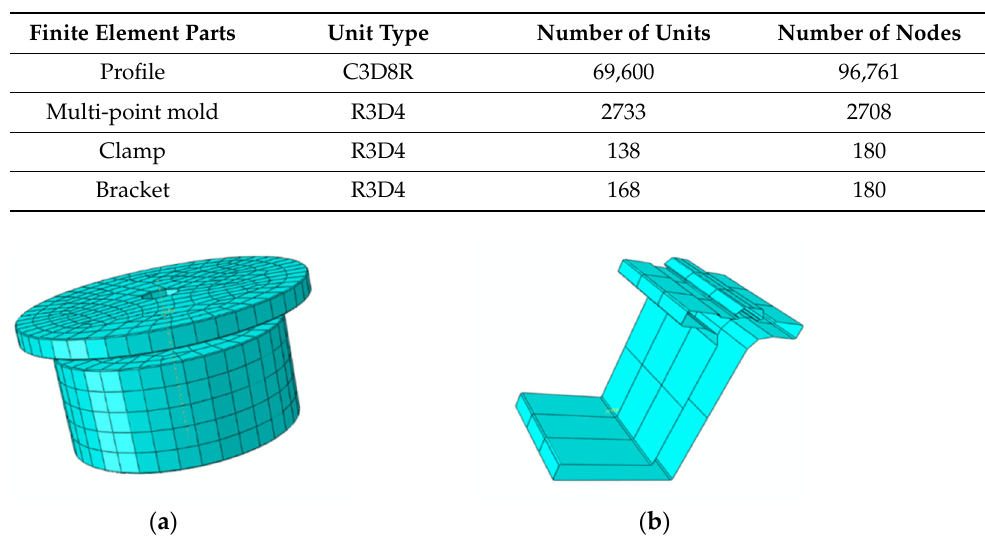
Table 2. Finite element model components, element types, number of elements and number of nodes.